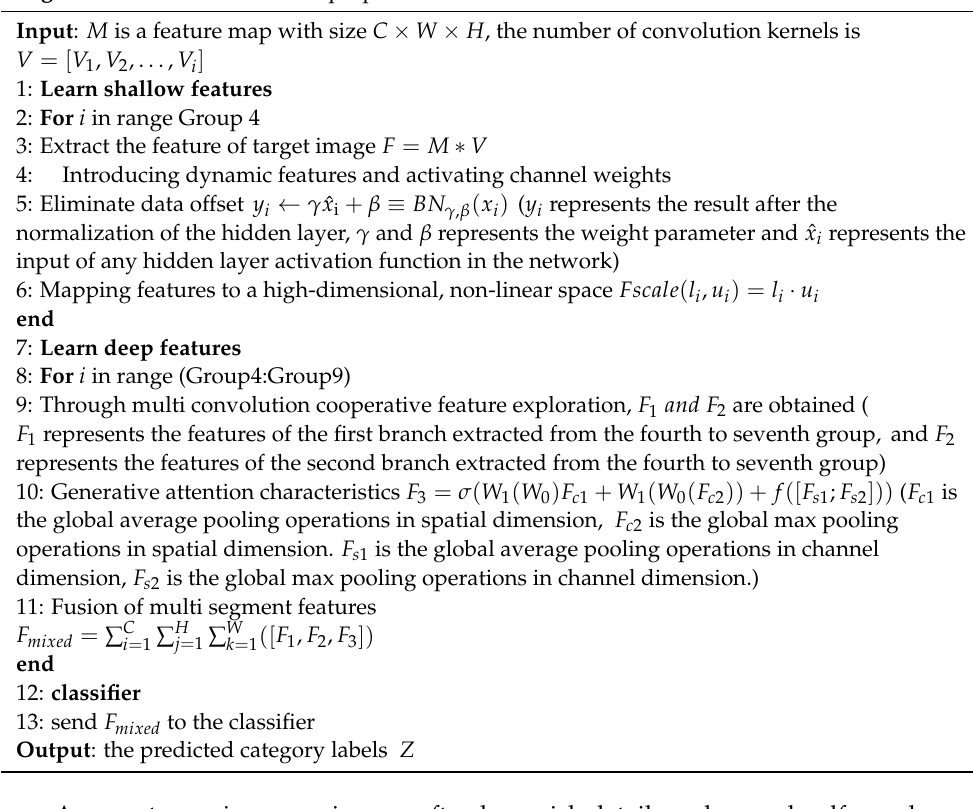
Algorithm 1 Framework of the proposed AMB-CNN